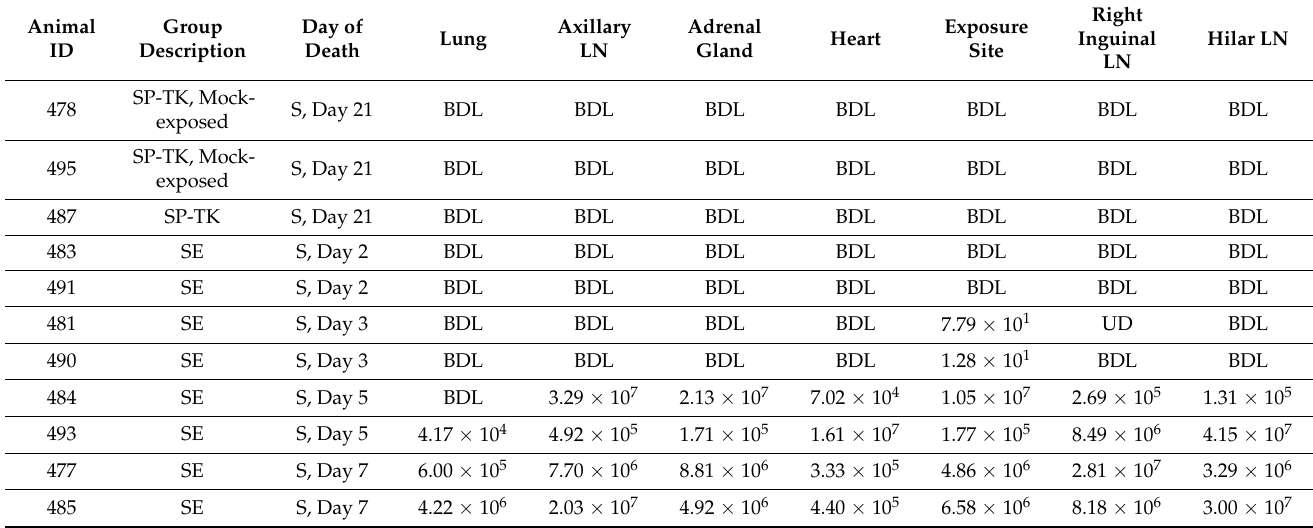
Table 4. Viral Load in Tissues as Determined by Plaque Assay